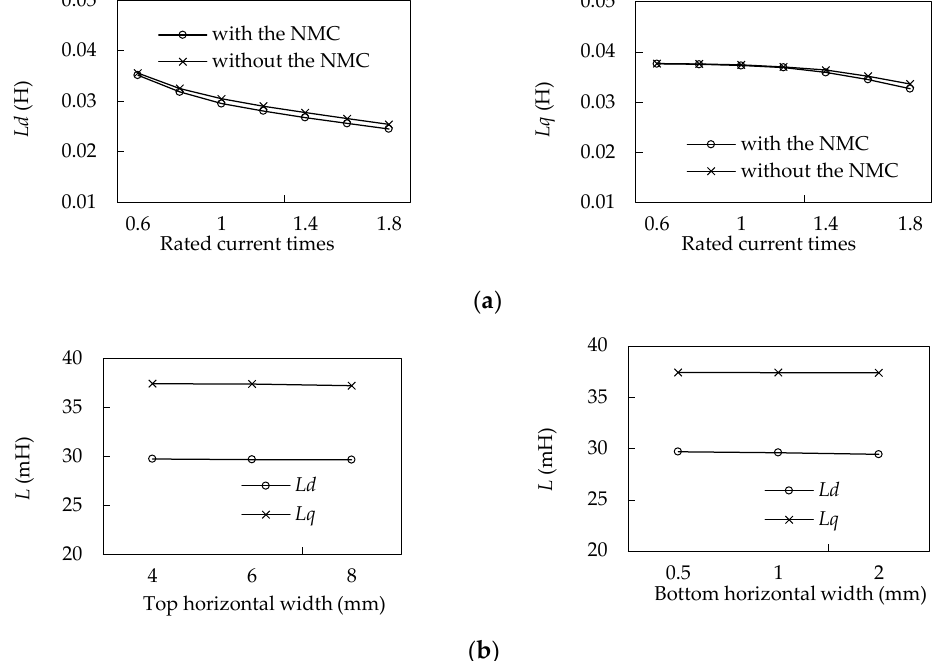
Figure 18. The effect of the NMC on inductance: ( a ) the existence of the NMC in the rotor; ( b ) the different NMC sizes (rated current).